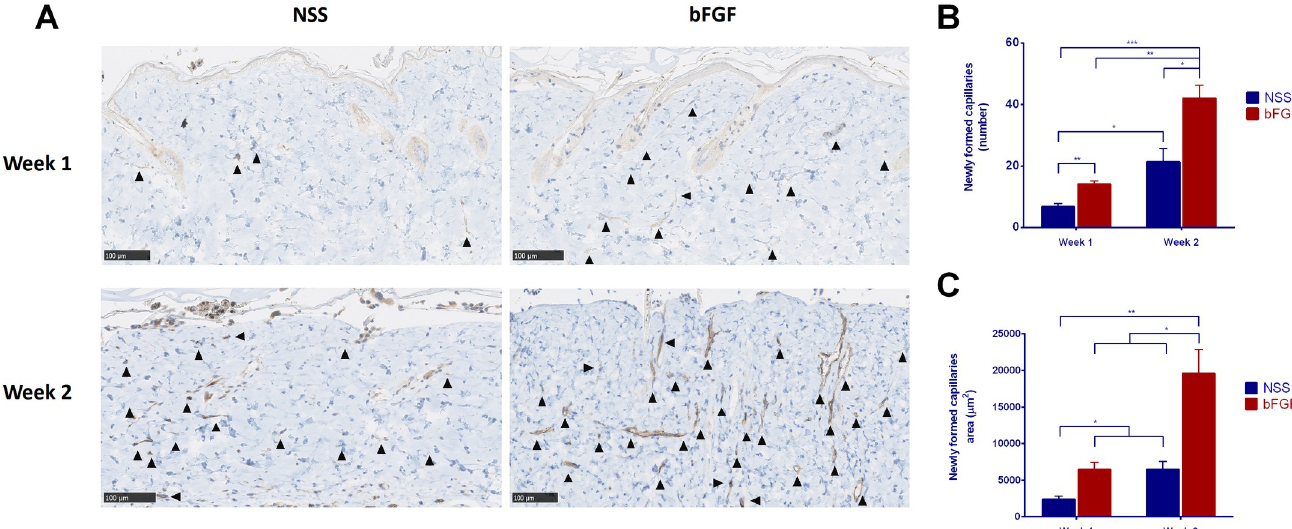
Fig 5. Evaluation of newly formed capillaries after implantation. (A) Micrographs of immunohistochemical staining of anti-CD31 at Weeks 1 and 2. Few capillaries were observed at Week 1 in both groups. The capillaries increased in number and size at Week 2 in both groups. ▲ : newly formed capillary; magnification: 20x, scale bar: 100 μ m. (B) A comparison of the number of newly formed capillaries in the grafts. The number of capillaries significantly increased from Weeks 1 to 2 in both groups. The number of capillaries in the bFGF group was significantly higher than that in the NSS group at Weeks 1 and 2 ( � p < 0.05, �� p < 0.01, ��� p < 0.001). (C) A comparison of the newly formed capillaries area in the grafts. The area of the capillaries also significantly increased from Weeks 1 to 2 in both groups. The number of capillaries in the bFGF group was significantly higher than that in the NSS group at Weeks 1 and 2 ( � p < 0.05, �� p < 0.01).